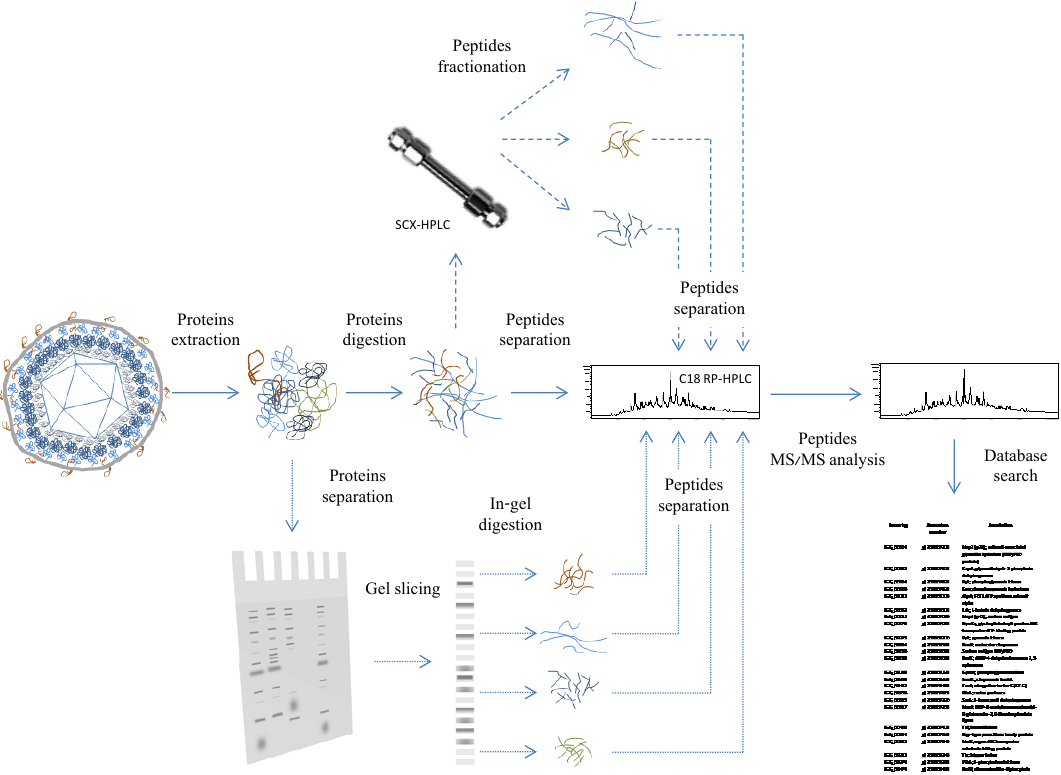
Figure 1. Common proteomic workflows that are applied for determination of the structural proteome. In shotgun proteomic analysis (solid lines), the proteins are extracted, digested in solution and derived peptides are separated according to their hydrophobicity using reversed phase reverse phase-high-performance liquid chromatography (RP-HPLC) and submitted to tandem mass spectrometry (MS/MS) analysis. Alternatively, proteome coverage can be enhanced by protein separation using sodium dodecyl sulfate polyacrylamide gel electrophoresis (SDS-PAGE) (dotted lines). Enzymatic digestion in this case takes place “in-gel” and eluted peptides are then submitted to liquid chromatography (LC)-MS/MS as in the shotgun analysis. This type of strategy is efficient in reducing the impact of the high dynamic range of the concentration. In Multi-Dimensional Protein Identification Technology (MuDPIT) approaches (dashed lines), protein digestion takes place in solution as in shotgun analyses but the peptide separation is performed using two-dimensional chromatography. Peptides are separated according to their charge using strong cation exchange (SCX) chromatography followed by the usual reverse phase chromatography as in the shotgun analysis. The number of fractions obtained from SCX chromatography needs to be adapted based on the sample complexity and usually ranges from 3 to 10.